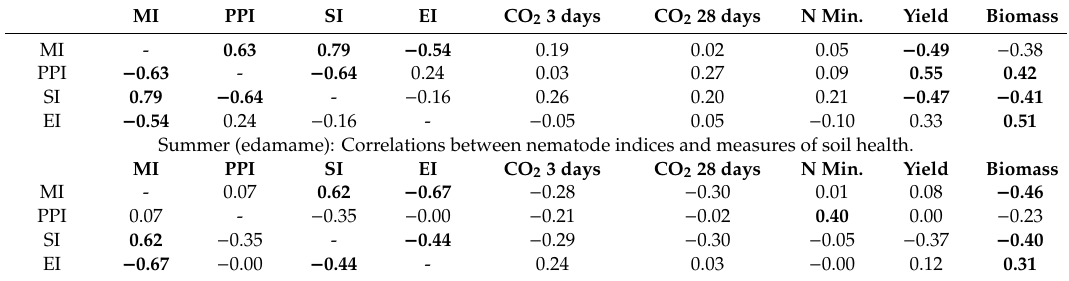
Table 4. Winter (wheat): Correlations between nematode indices and measures of soil